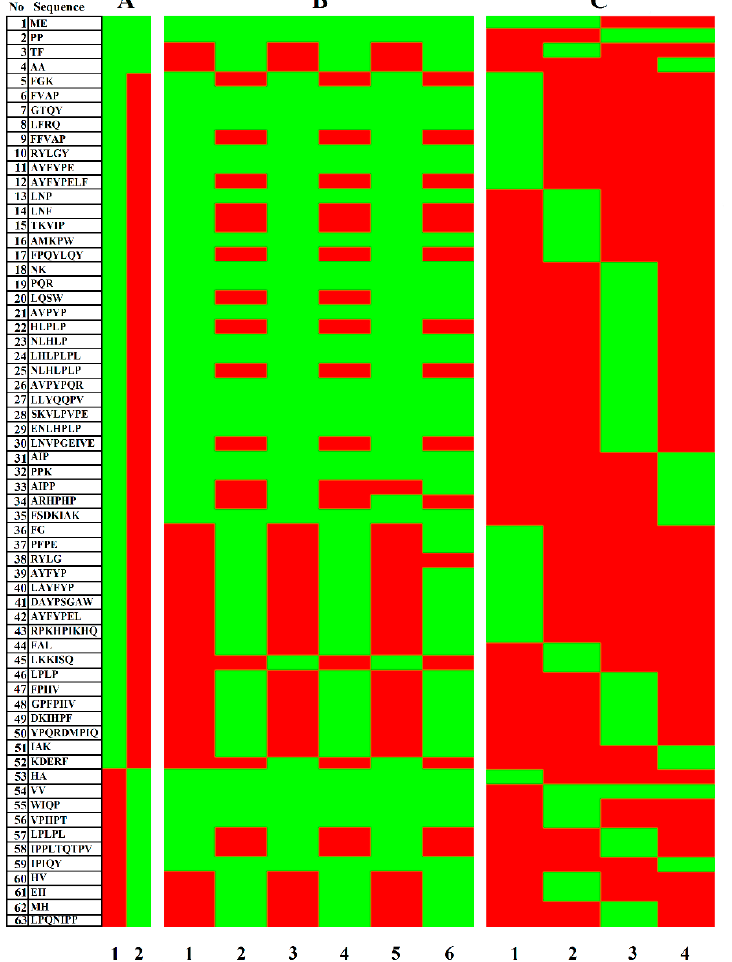
Figure 4. Heatmap of ACE and DPP-IV inhibitors identified in Gouda cheese samples. Figure prepared using the Heatmapper program [55,56]. Map ( A ) (activity): ACE inhibition (A1), DPP-IV inhibition (A2); map ( B ) (peptide presence in a cheese sample): ChCN ↓ -1 (B1), ChCN ↓ -60 (B2),